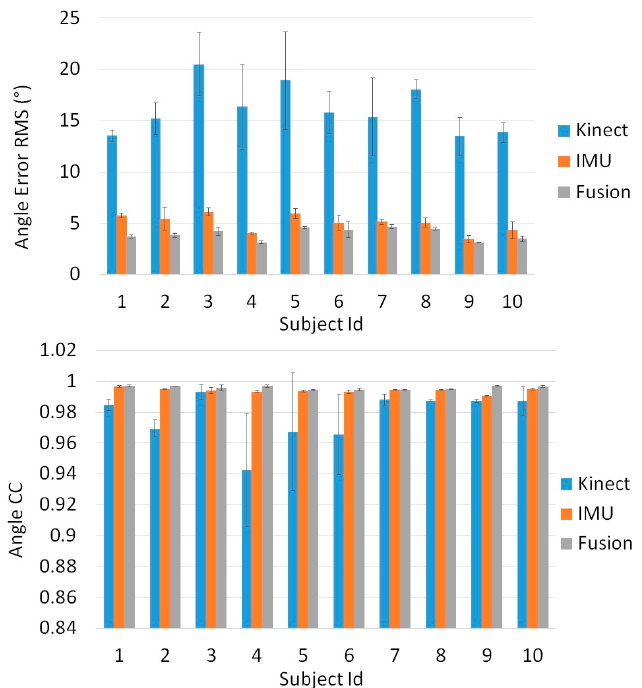
Figure 7. Angle error RMS (°) and angle Correlation Coefficient calculated for the Kinect, IMU and the proposed fusion algorithm Vs the universal goniometer, when IMU sensors are placed in the sagittal plane position.